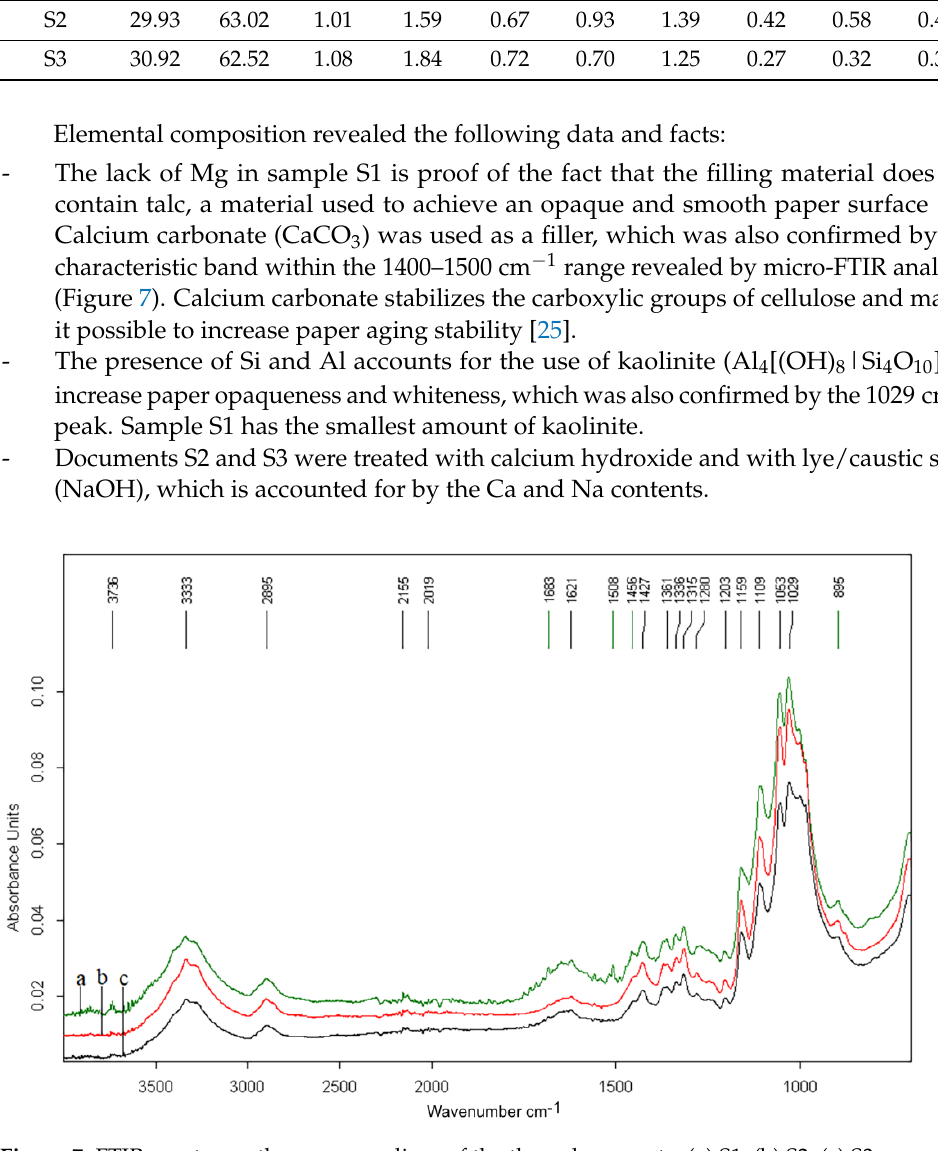
Figure 7. FTIR spectra on the paper medium of the three documents: ( a ) S1; ( b ) S2; ( c )